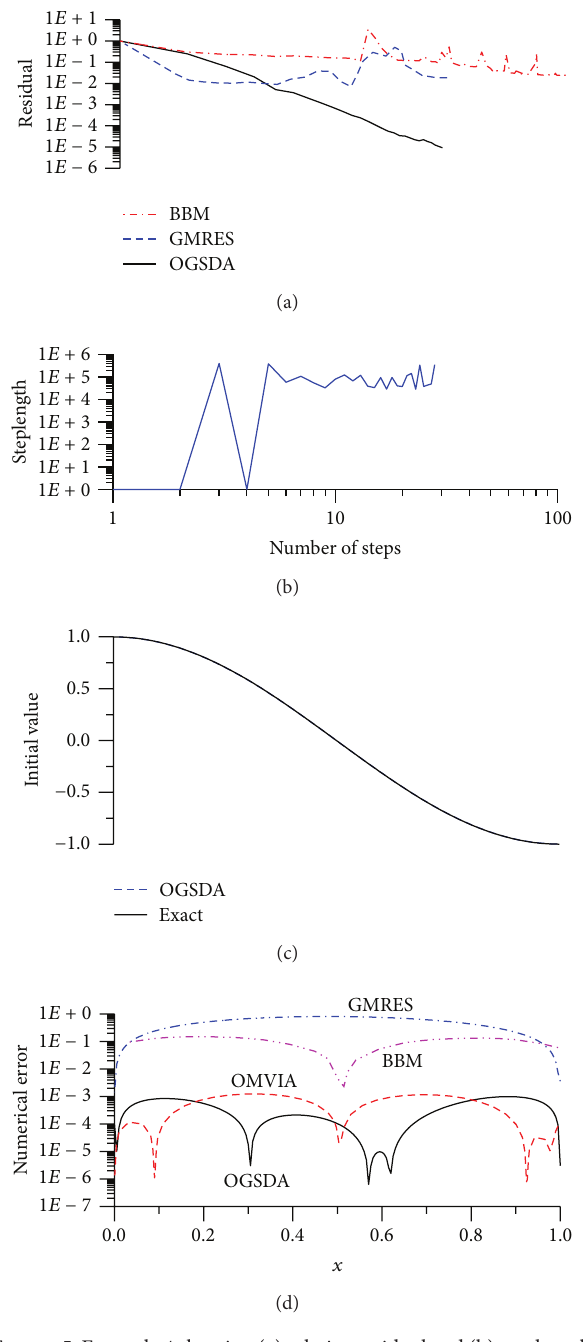
Figure 5: Example 4 showing (a) relative residual and (b) steplength of OGSDA, (c) comparing numerical and exact initial value, and (d) comparing numerical errors of OMVIA, OGSDA, BBM, and